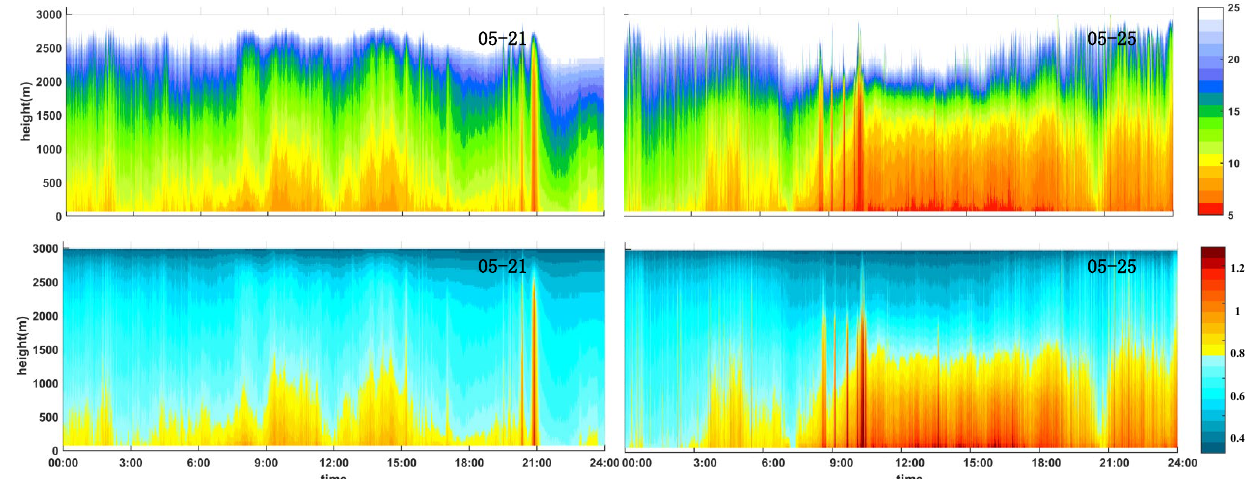
Figure 11. Spatiotemporal distribution of r 0 and ε during the two days.